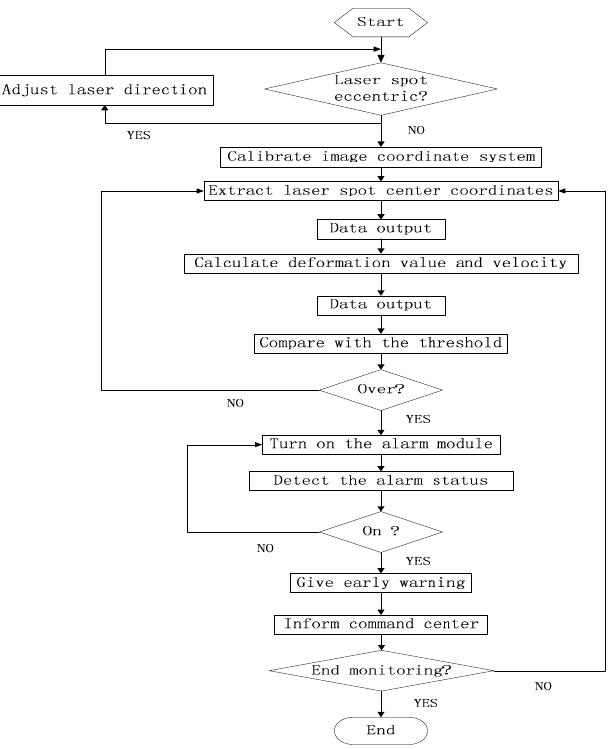
Figure 8. Flowchart of the system software.